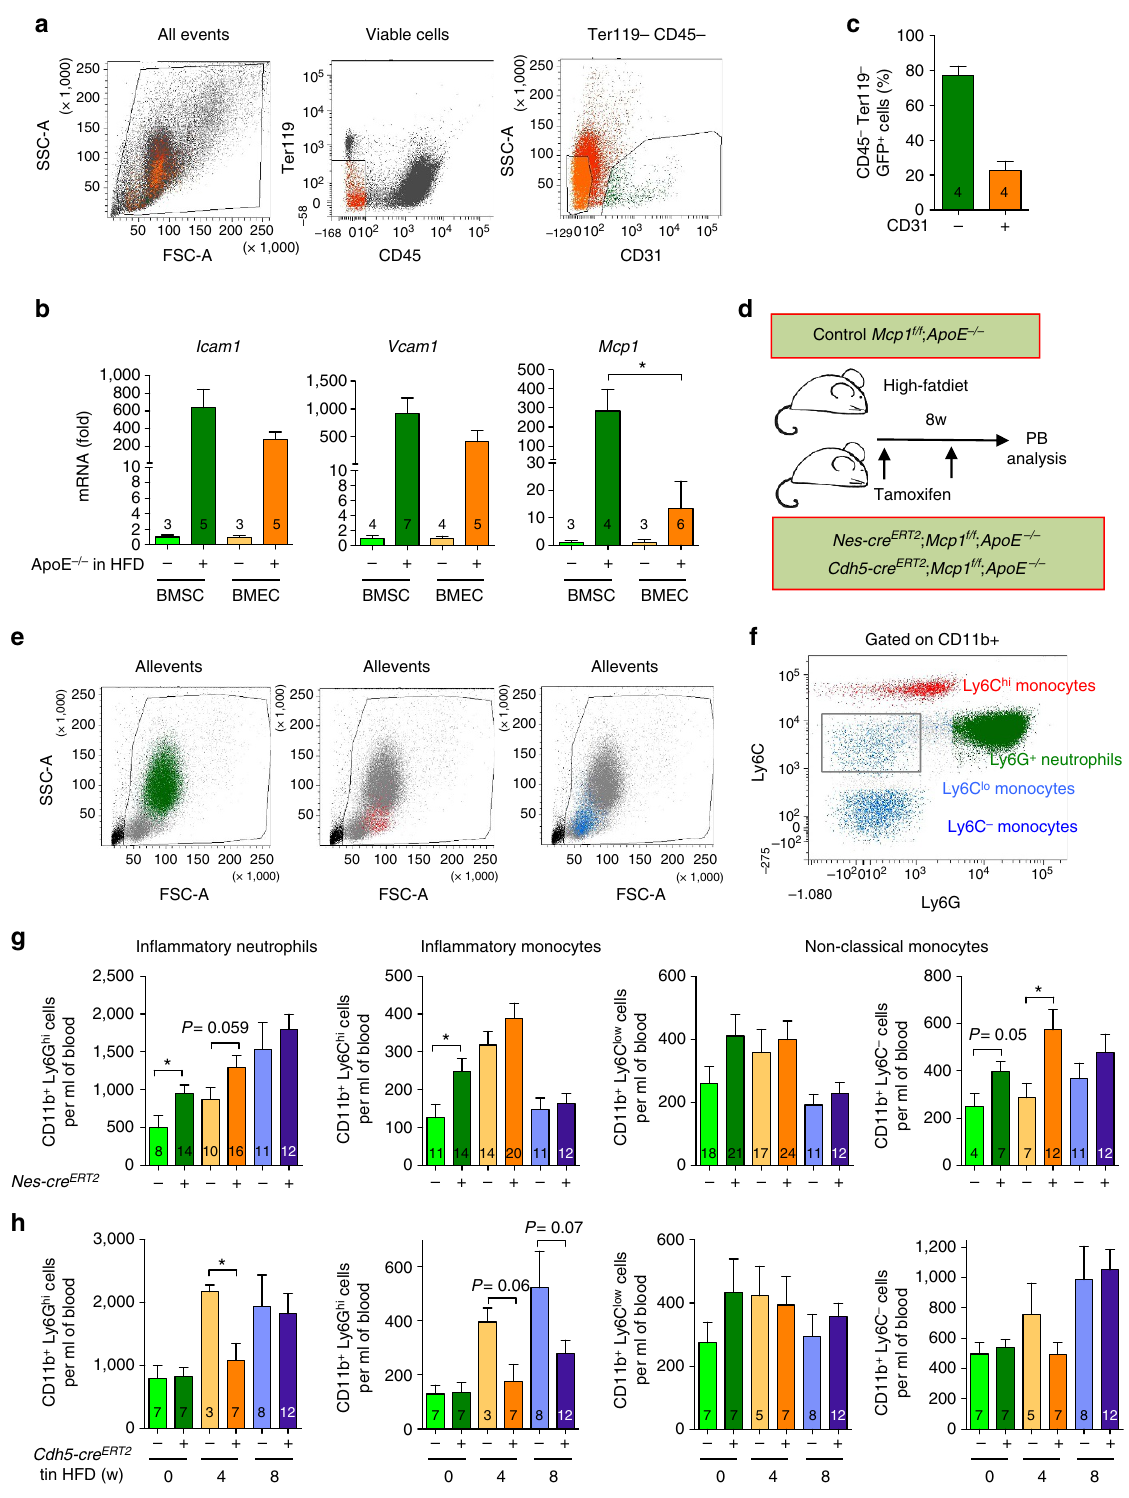
Figure 1 | Nestin þ cells regulate inflammatory cell traffic in atherosclerosis. ( a ) Flow cytometry plots showing the cell sorting strategy. ( b ) QPCR analysis of Icam1 , Vcam1 and Mcp1 mRNA in BM CD45 (cid:2) Ter119 (cid:2) CD31 þ endothelial cells (BMEC) and BM CD45 (cid:2) Ter119 (cid:2) CD31 (cid:2) stromal cells (BMSC) from ApoE (cid:2) / (cid:2) mice fed with chow or HFD for 2 months ( n ¼ 3–7). ( c ) CD31 expression in BM GFP þ stromal cells from Nes-gfp;ApoE (cid:2) / (cid:2) mice fed with HFD for 2–3 months ( n ¼ 4). ( d ) Experimental design of peripheral blood analysis from mice treated with tamoxifen and fed with HFD for 2 months. ( e , f ) Flow cytometry strategy used to identify inflammatory neutrophils, inflammatory monocytes and non-classical monocytes. ( g , h ) Number of non- classical monocytes, inflammatory monocytes and inflammatory neutrophils in the peripheral blood of tamoxifen-treated ( g ) Nes-Cre ERT2 ;Mcp1 f/f ; ApoE (cid:2) / (cid:2) mice, ( h ) Cdh5-Cre ERT2 ;Mcp1 f/f ; ApoE (cid:2) / (cid:2) mice and control littermates ( n ¼ 3–12). Data are means ± s.e.m.; n and P values are indicated; * P o 0.05, unpaired two-tailed t